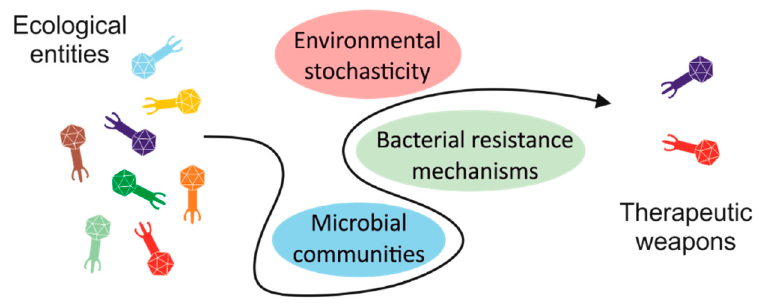
Figure 1. Schematic illustration summarising the obstacles that bacteriophages must overcome to be considered as antibacterial weapons.